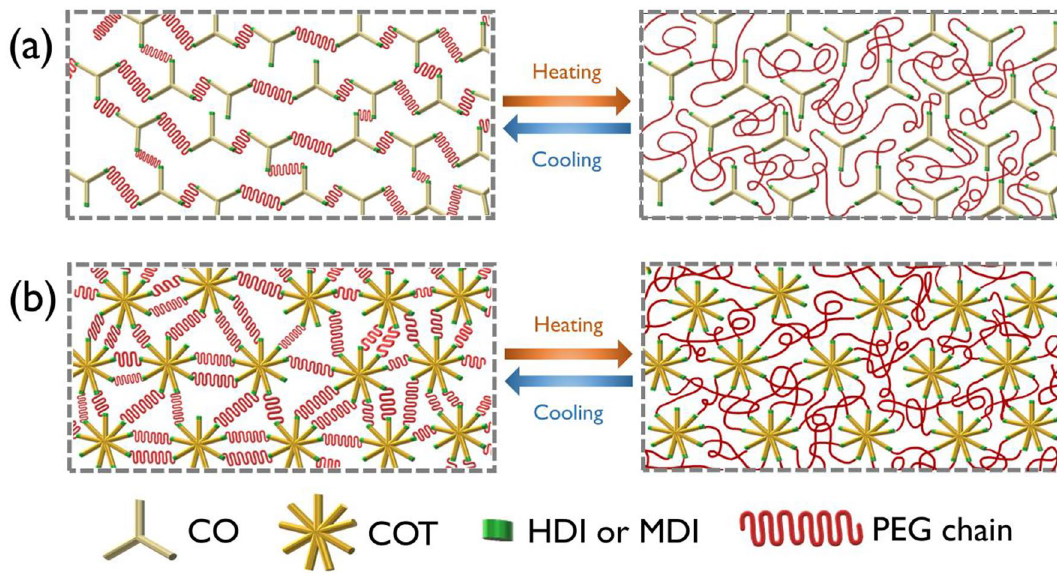
Figure 6. Schematic illustration of the phase change mechanisms of the SSPCMs crosslinked with ( a ) CO and ( b ) COT.